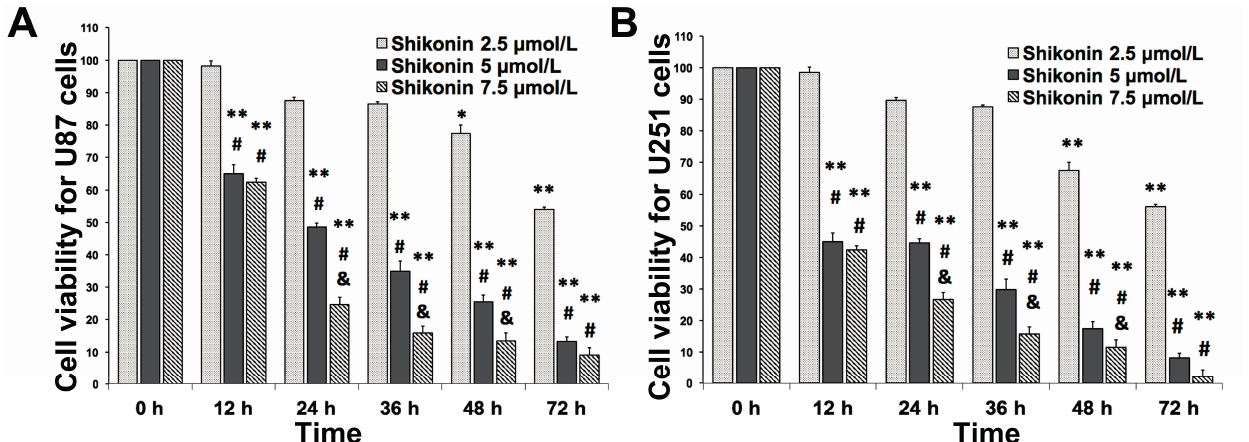
Figure 1. Effects of shikonin on the proliferation of U87 and U251 cells. U87 and U251 cells were treated with shikonin at 2.5, 5, and 7.5 μ mol/L for 0–72 h. The cell viability rate was assayed by CCK-8. Shikonin inhibited the proliferation of both cell lines in a time-dependent manner. Doses of 5 and 7.5 μ mol/L led to stronger inhibition than 2.5 μ mol/L. A dose of 7.5 μ mol/L displayed the strongest inhibitory effect from 24 to 48 h and the difference between 5 and 7.5 μ mol/L was not significant at 12 and 72 h. ( A ) CCK-8 results of U87 cells; ( B ) CCK-8 results of U251 cells. Data is given as mean ± SD of individual experiments with five plates in each experiment. * p < 0.01 vs. 0 h; ** p < 0.01 vs. 12 h; # p < 0.01 vs. 2.5 μ